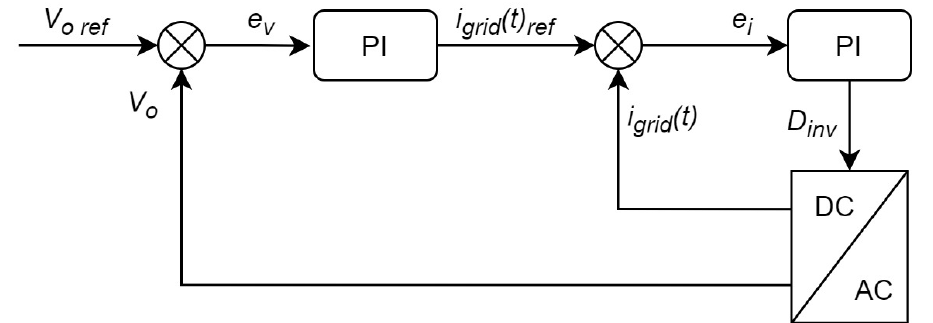
Figure 6. PI current control